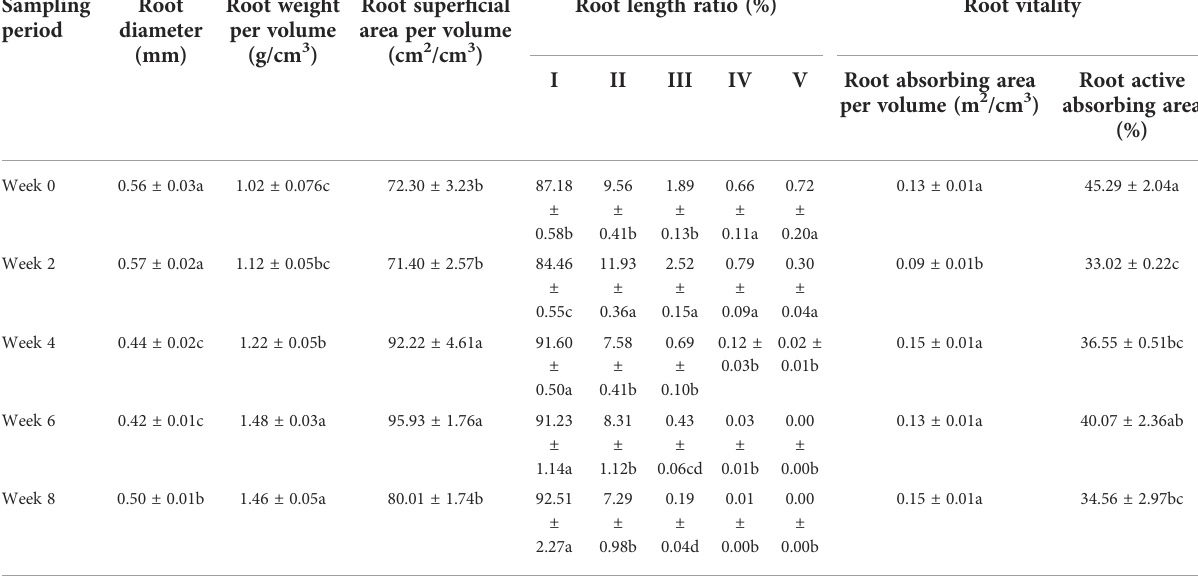
TABLE 2 Dynamics of root morphology and root vitality of L. japonica during the senescence stage.